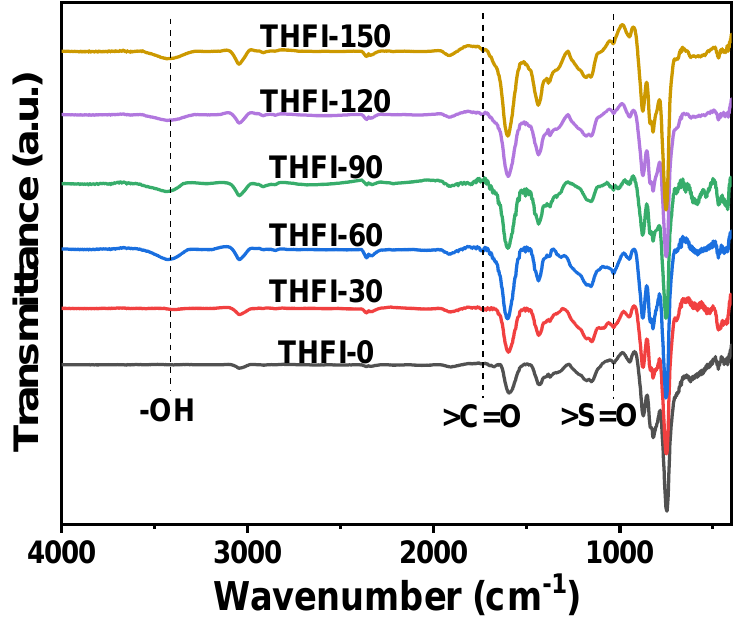
Figure 13. FT-IR spectra of the THFI Figure 13. FT − IR spectra of the THFI fraction.